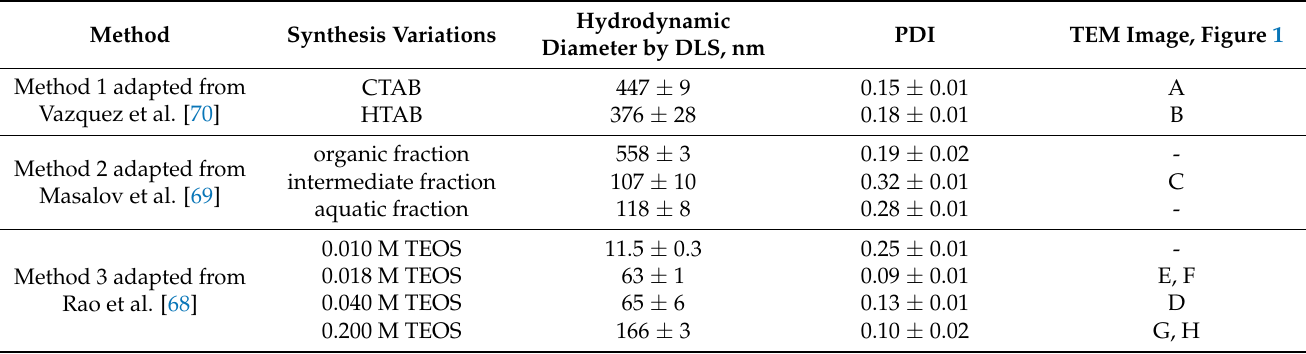
Table 1. Hydrodynamic diameter, polydispersity index (PDI), and variable parameters for SiNPs